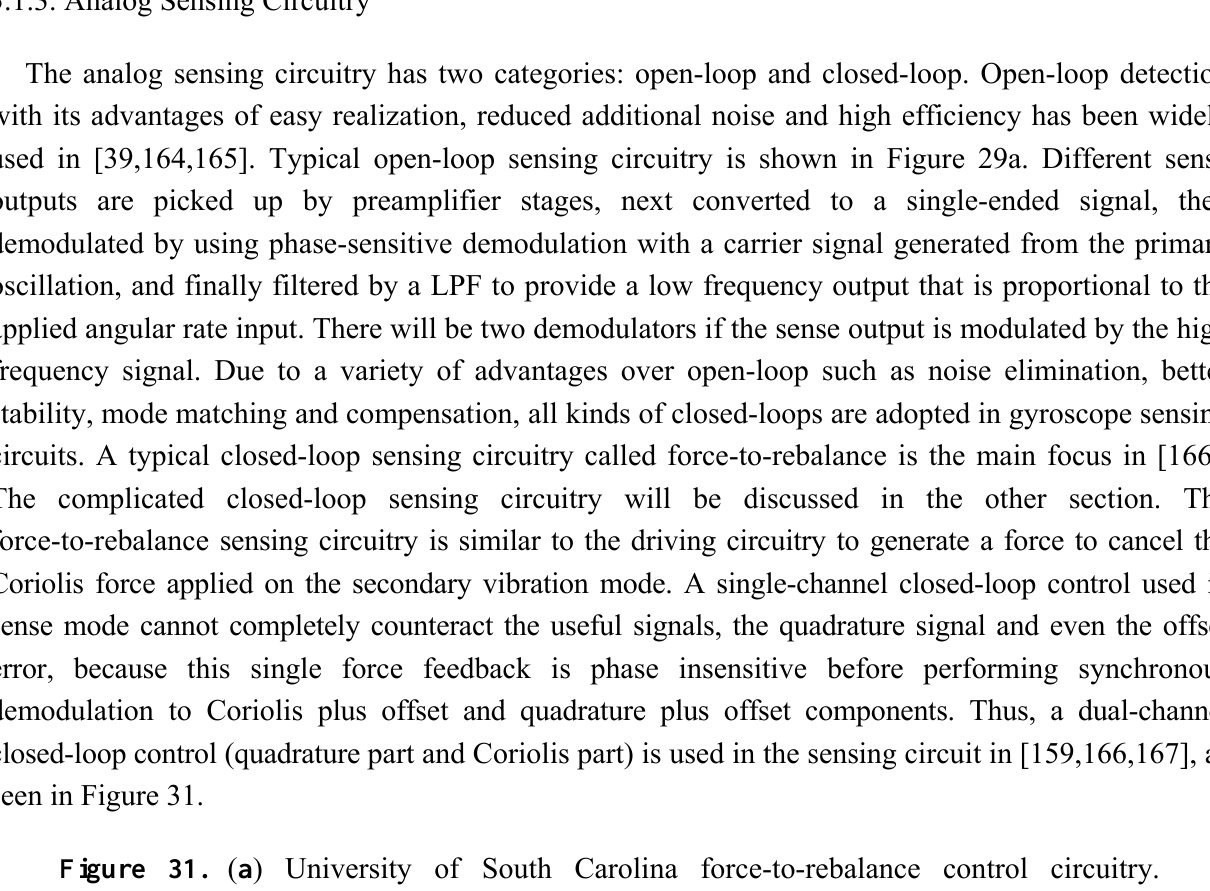
Figure 31. ( a ) University of South Carolina force-to-rebalance control